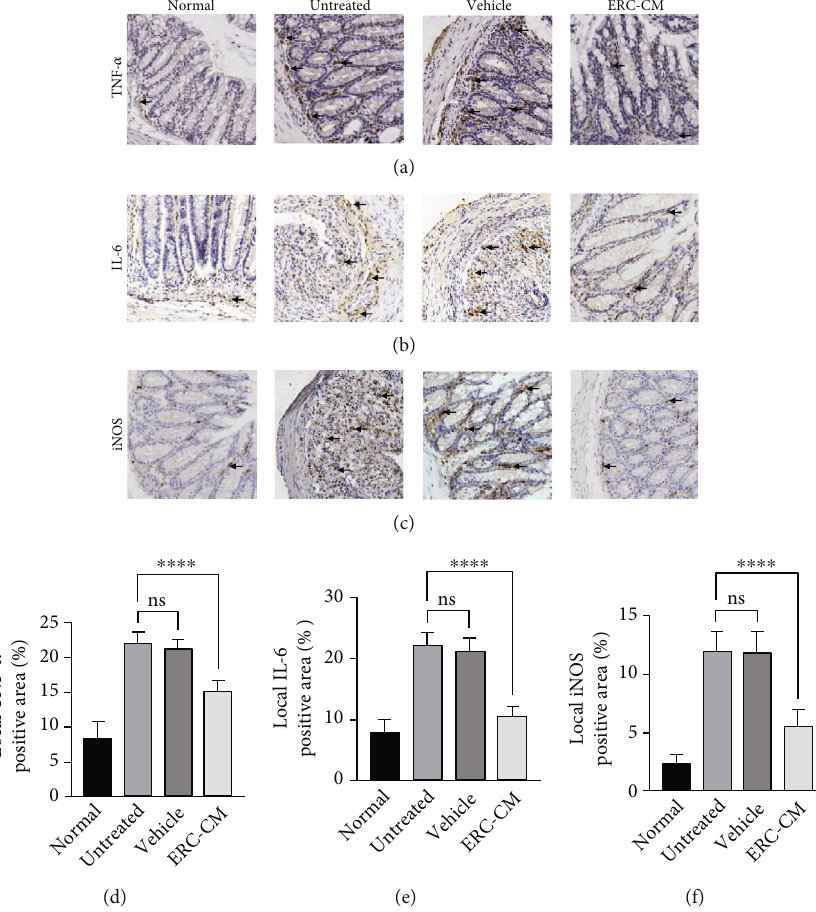
Figure 6: ERC-CM decreased the level of proin fl ammatory cytokines and macrophage in fi ltration in the colon. In fl ammatory factor levels and macrophage in fi ltration in the colon were assessed by immunohistochemical staining. Speci fi cally, TNF- α , IL-6, and M1 macrophage in fi ltration were detected by iNOS staining. Images of IHC staining (200x) for the mouse colon (a – c) and quantitative data of cell counts for each group (d – f) are shown. The p value was determined by one-way ANOVA. ∗ p < 0 : 05 , ∗∗ p < 0 : 01 , ∗∗∗ p < 0 : 001 , and ∗∗∗∗ p < 0 : 0001